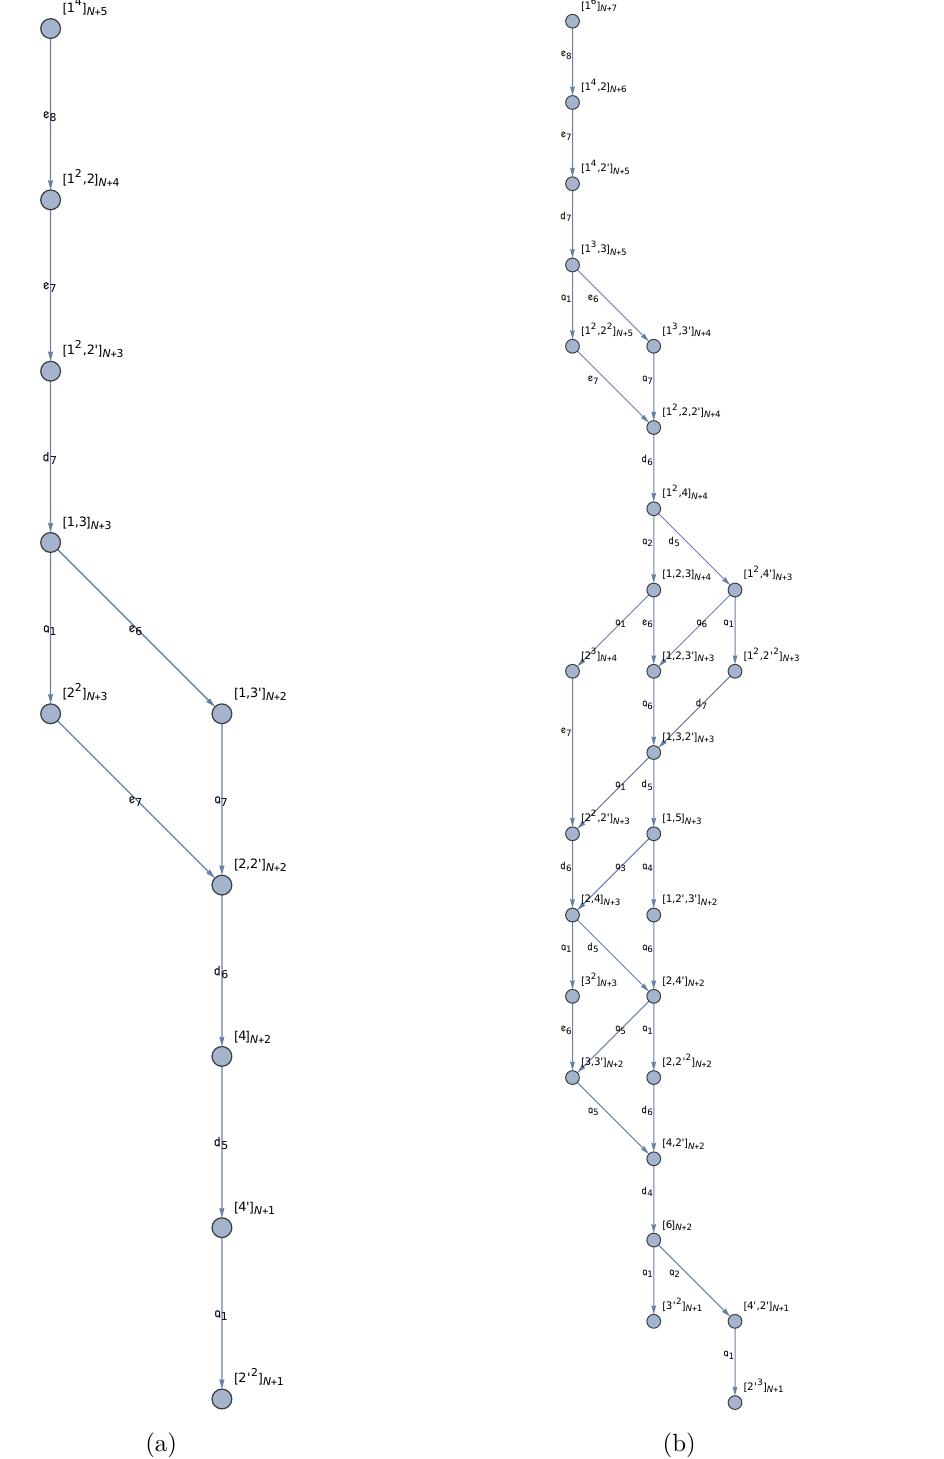
Figure 6. Hierarchy of RG flows for (a) massive E 8 -theories with n 0 = 1 and k = 5 (i.e. orbi- instanton at k 0 = k − n = 5 − 1 = 4 ); (b) massive E 0 orbi-instanton at k 0 = 7 − 1 = 6